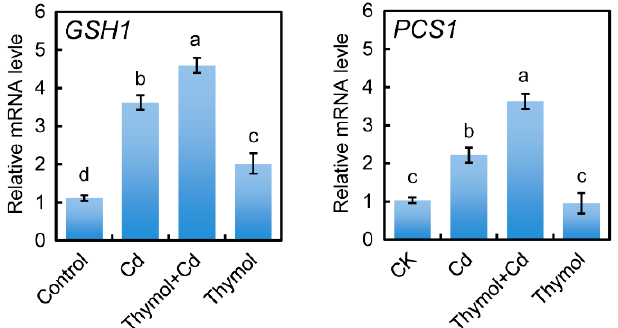
Figure 8. The effect of thymol on the expression of GSH1 and PCS1 in the roots of tobacco seedlings under Cd stress. The roots of seedlings were treated with water (control), CdCl 2 (20 μ M), CdCl 2 (20 μ M) + thymol (100 μ M), and thymol (100 μ M) for 72 h. Then the roots were harvested for RNA extraction and real-time PCR analysis. Different letters indicate that the mean values of three replicates are significantly different between the treatments ( p < 0.05, ANOVA, LSD).